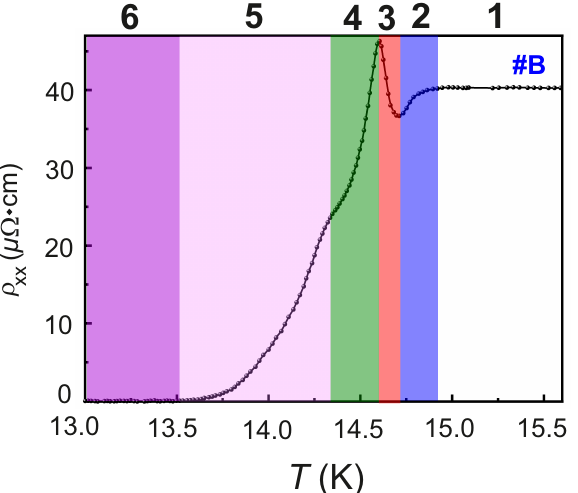
Figure 5. ZFC ρ xx as a function of T . The six electronic phases and the phase boundaries of #B. are